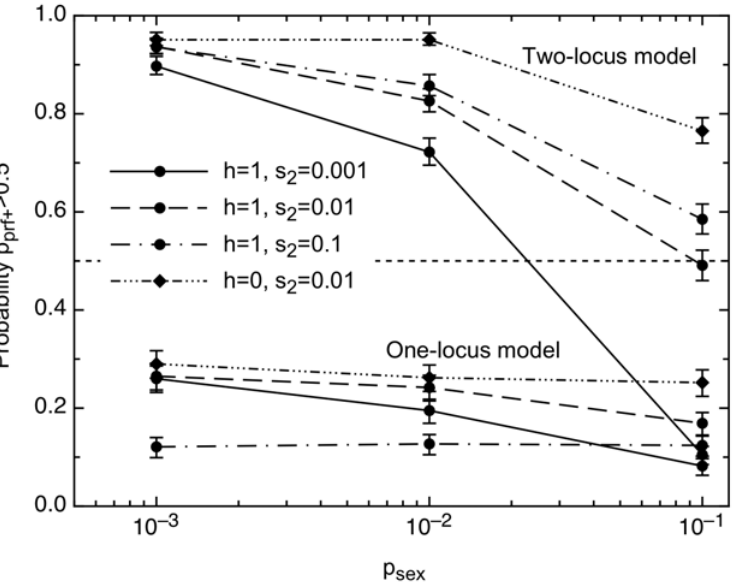
Figure 4. prf + is maintained in the two-locus but not the one-locus model. The y -axis gives the probability that the frequency of prf + after 5 6 10 5 generations is greater than its starting frequency of 0.5. The strength of selection s 2 for adaptation in environment 2 affects the cutoff frequency of sex. e =0.01, V 12 = V 21 =10 2 5 . prf + is maintained in the two-locus model unless sex is very frequent.